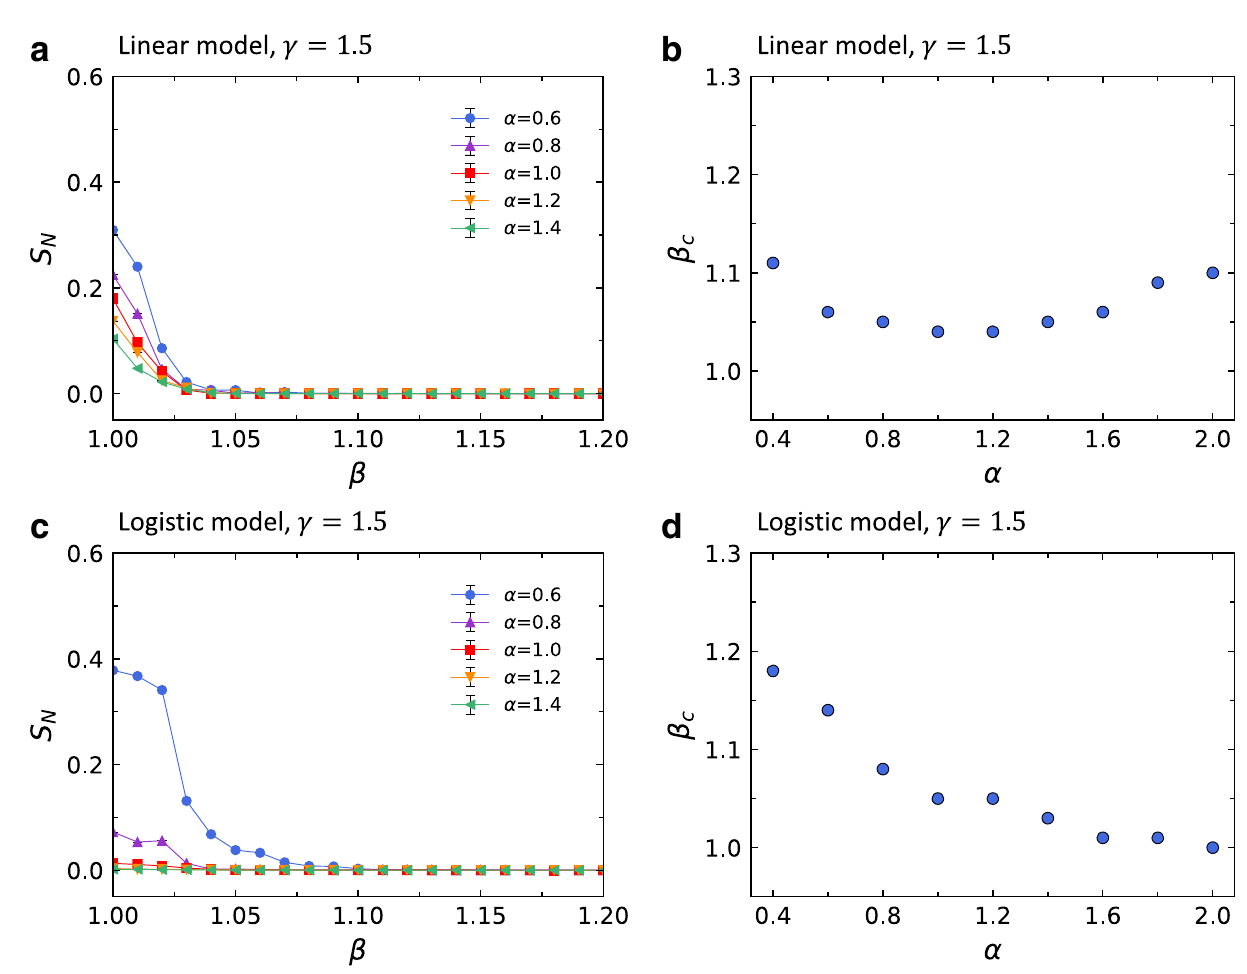
Figure 5. The robustness of airport network based on the linear and the logistic models. Dependence of the order parameter S N on the tolerance parameter β in Eq. (2) with ( a ) linear model with γ = 1.5 , and ( c ) logistic model with γ = 1.5 and the critical threshold β c as a function of the parameter α in Eq. (1) with ( b ) linear model with γ = 1.5 , and ( d ) logistic model with γ = 1.5 are